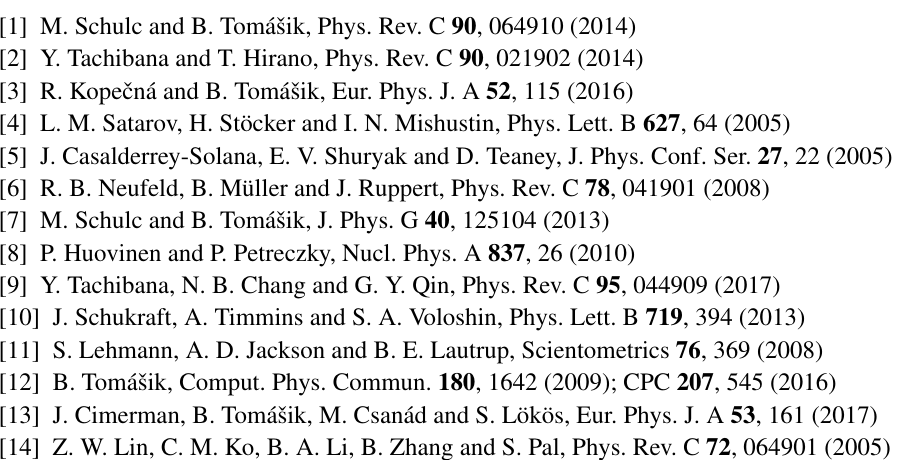
tions and correlation radii together at the same time. This should allow for a more di ff erential comparison of theory to